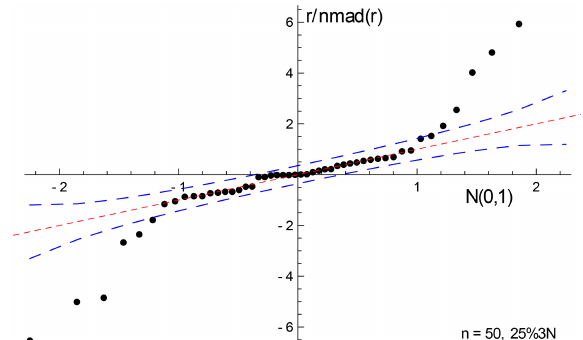
Figure E2. Quantile–quantile plot, for example, in Fig. E1. See